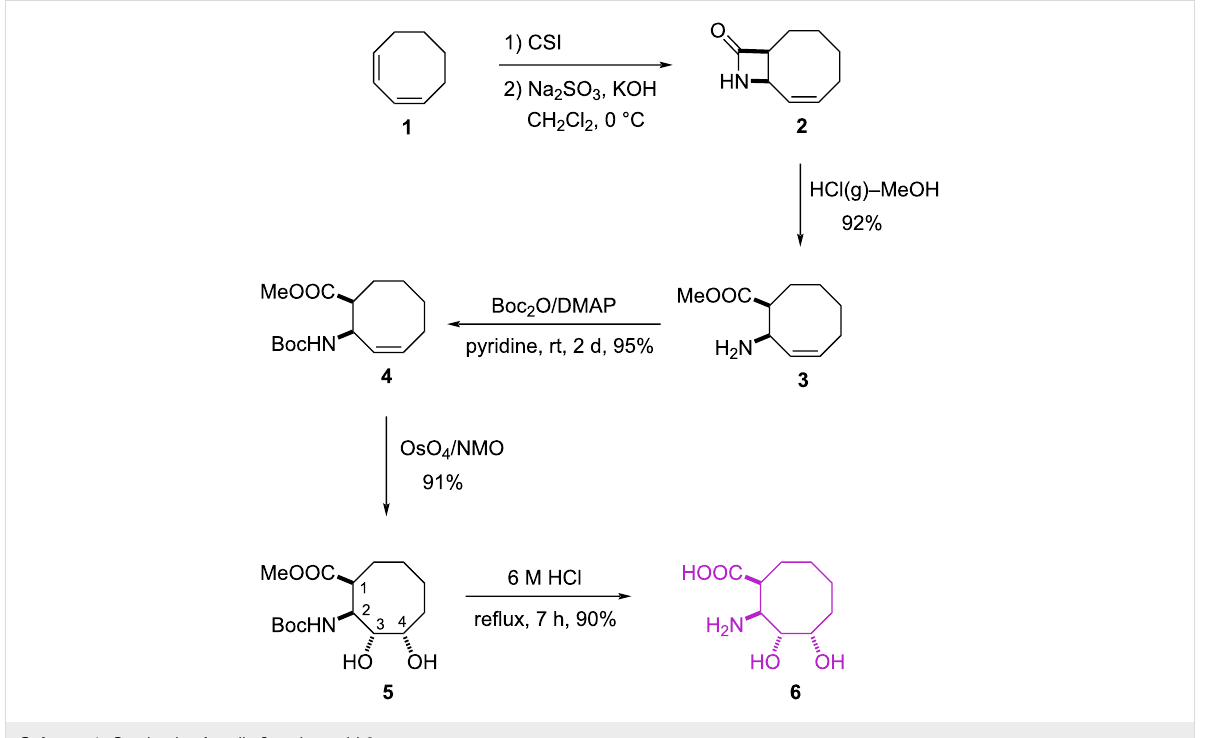
Scheme 1: Synthesis of cyclic β -amino acid 6